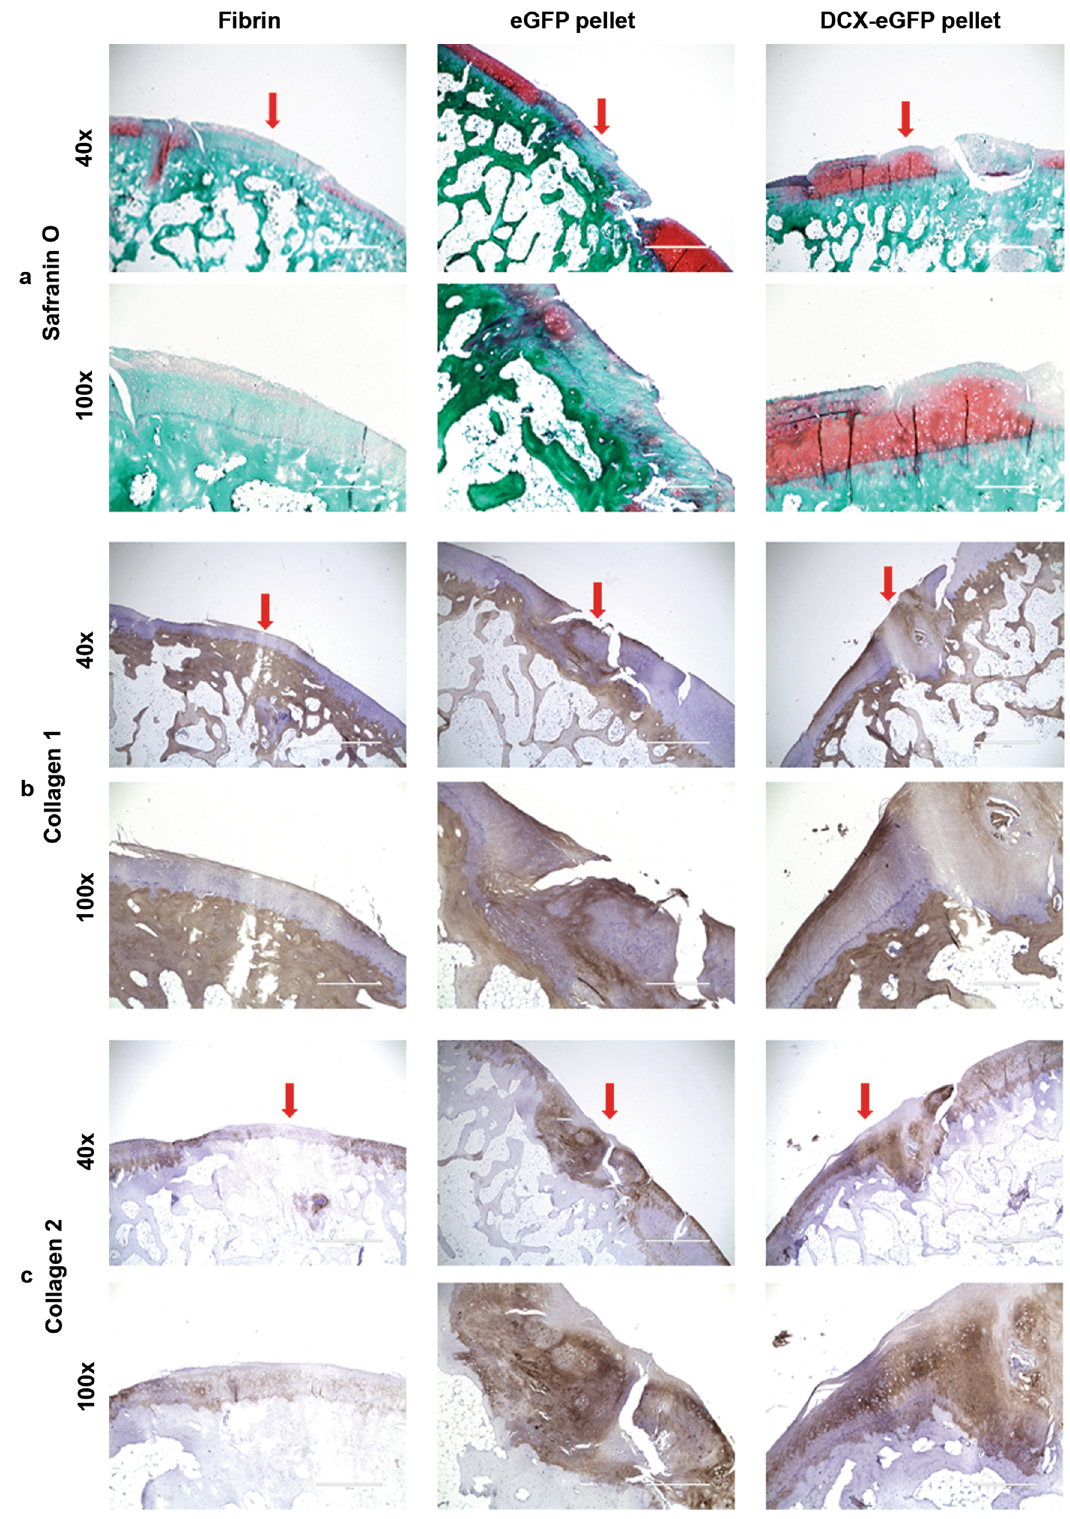
Fig. 4 Representative photomicrographs of rabbit cartilage tissue sections at 12 months after surgery. a Safranin O staining. b Immunohistochemical staining of collagen 1. c Immunohistochemical staining of collagen 2. Arrows, the repaired cartilage defects. ×40 magni fi cation, scale bars = 1000 µm. ×100 magni fi cation, scale bars = 400